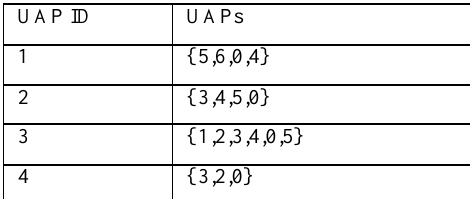
Table 1. Paths of mobile